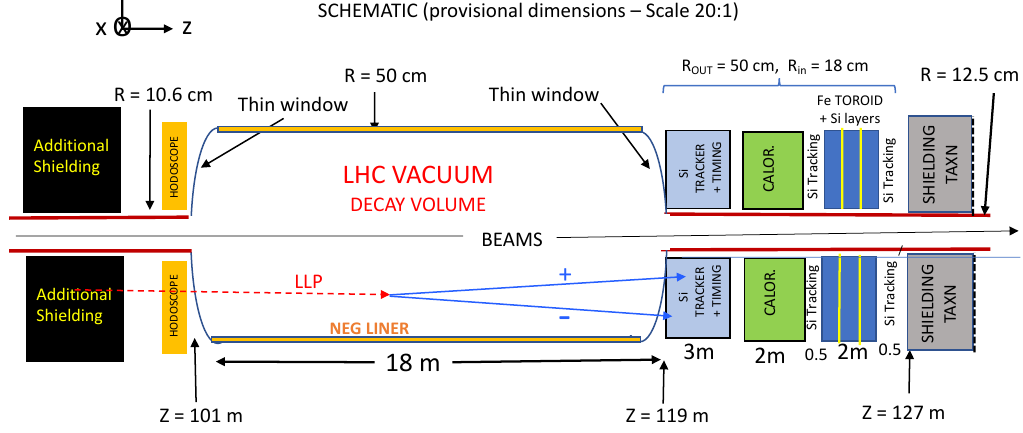
Figure 1 . Schematic layout of the proposed FACET spectrometer. Side view and top view are essentially the same since it is azimuthally symmetric. Upstream (to the left) is the IP5 collision region (at z = 0 ) followed by the machine elements Q1–Q3 and D1 comprising 35–50 m of iron shielding. The superimposed red dashed line shows schematically an LLP from the IP5 decaying into two charged tracks shown in blue. The TAXN copper absorber is conceived to intercept the neutral particles produced at the interaction point at the HL-LHC, in order to shield the superconducting magnets downstream. Its location limits the extent of FACET in the z